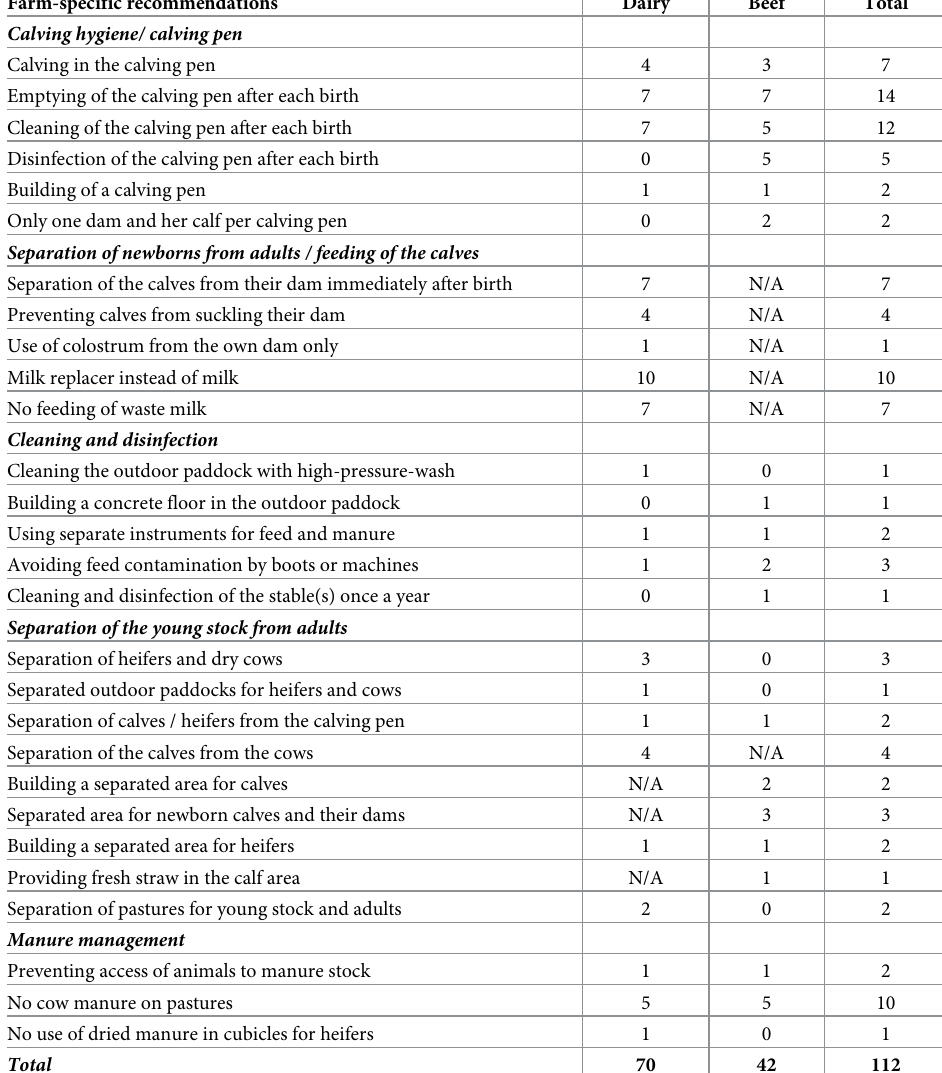
Table 2. Farm-specific recommendations given to the managers of ten dairy and seven beef farms to limit MAP spread on their farms. Farm-specific